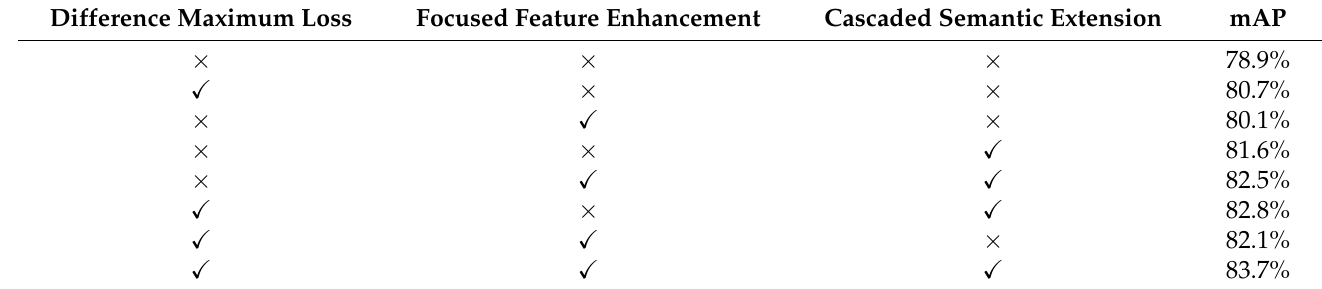
Table 3. The effectiveness of difference maximum loss, focused feature enhancement, and cascaded semantic extension. Difference Maximum Loss Focused Feature Enhancement Cascaded Semantic